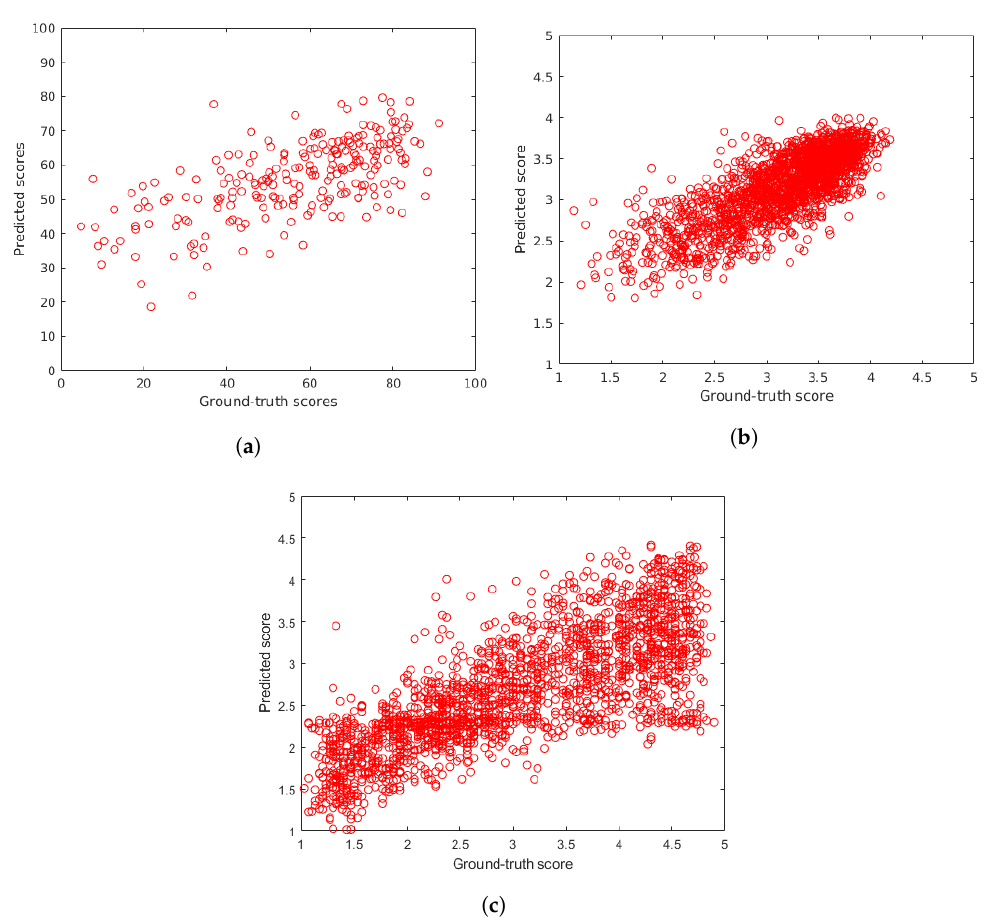
Figure 8. Ground-truth scores versus predicted scores using the proposed LFD-IQA-SVR method on